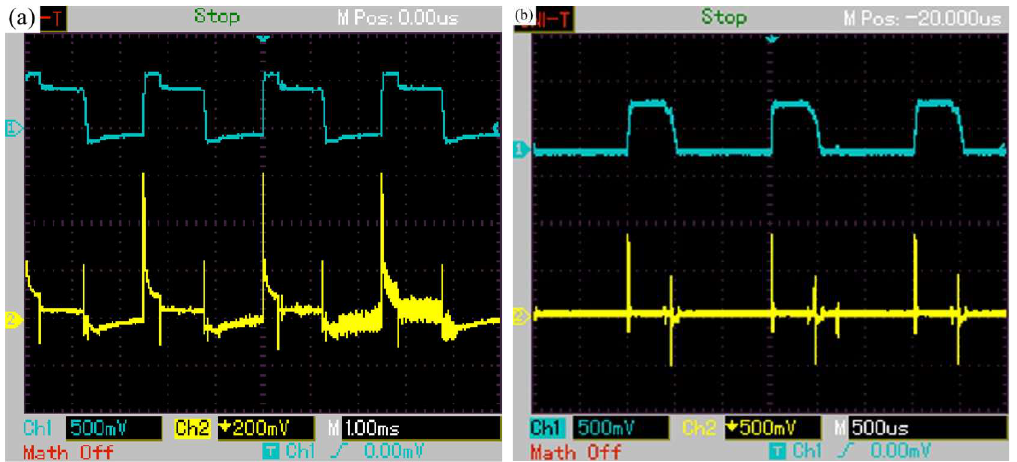
Figure 6. The load voltage and current waveform in micro-arc oxidation process. ( a ) bipolar pulse mode ( b ) the pulsed with a discharge loop current (DLC).